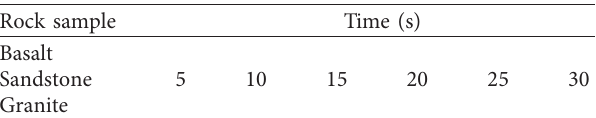
Figure 1: Experimental diagram of fiber laser perforation system. Table 2: Experimental parameters of laser irradiation time (laser power 45 W).